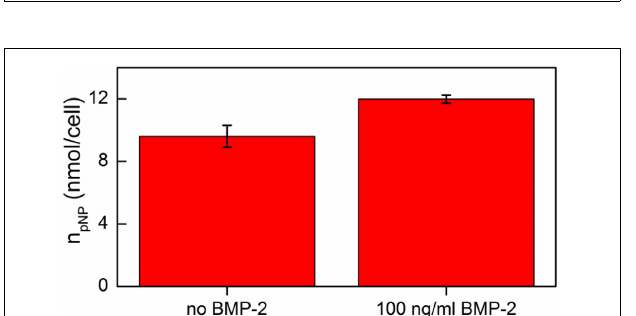
FIGURE 6 | Number of viable hMSCs cells grown for 7 days on the DR/Pec reference without insulin, DR/Pec surfaces with insulin at 36 μ M added to the culture medium (DR/Pec + Ins), and DR/Pec functionalized with insulin (DR/Pec/Ins) by irradiation in 36 μ M insulin solution.